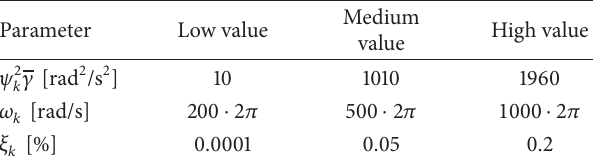
Table 4: Selected values for 𝜓 2 𝑘 𝛾,𝜔 𝑘 , and 𝜉 𝑘 .